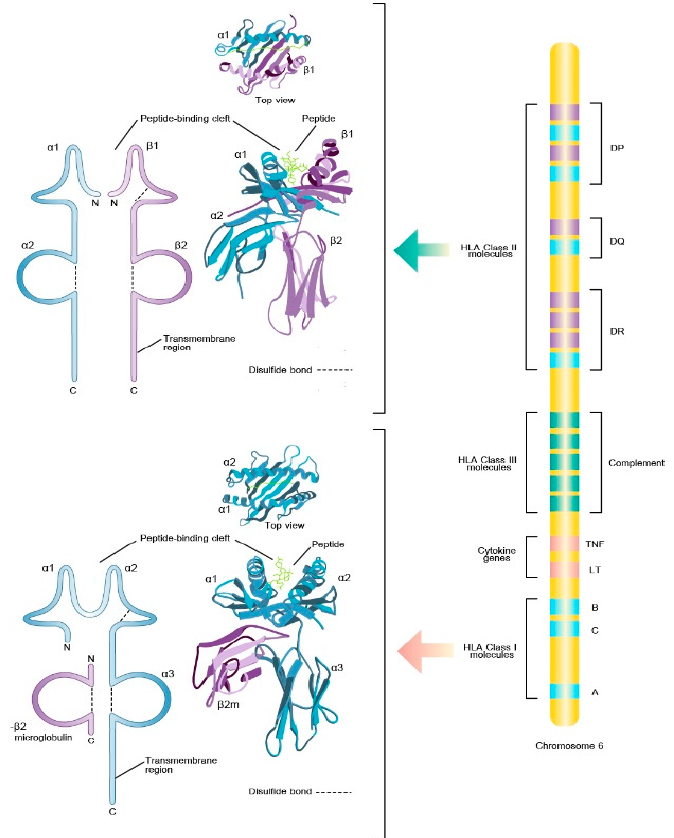
Figure 1. Human leukocyte antigen ( HLA ) is located on chromosome 6 and structure of HLA class I and class II molecules.